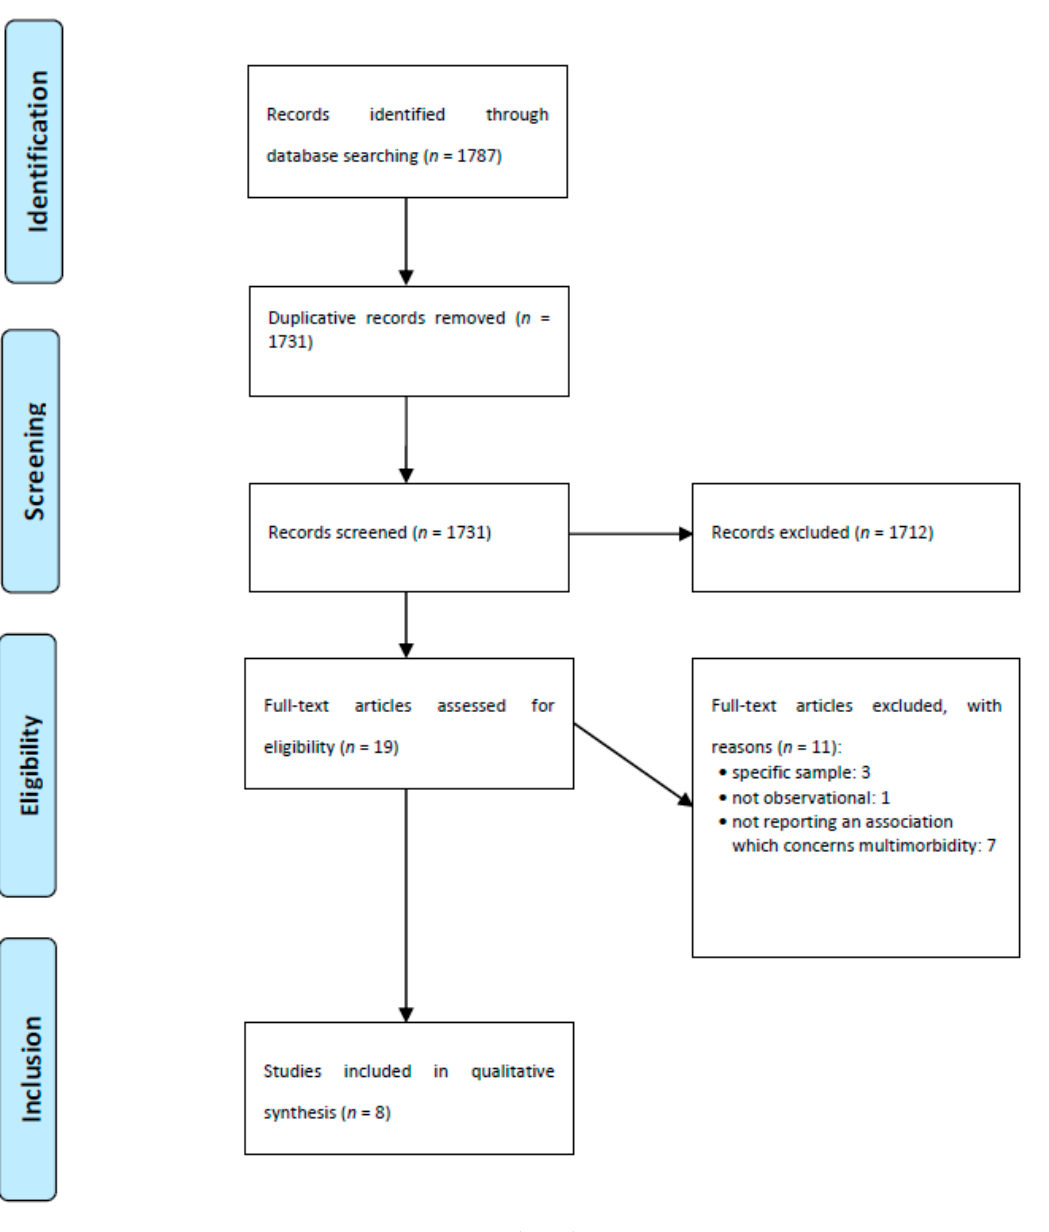
Figure 1. Flow Figure 1. Flow chart.